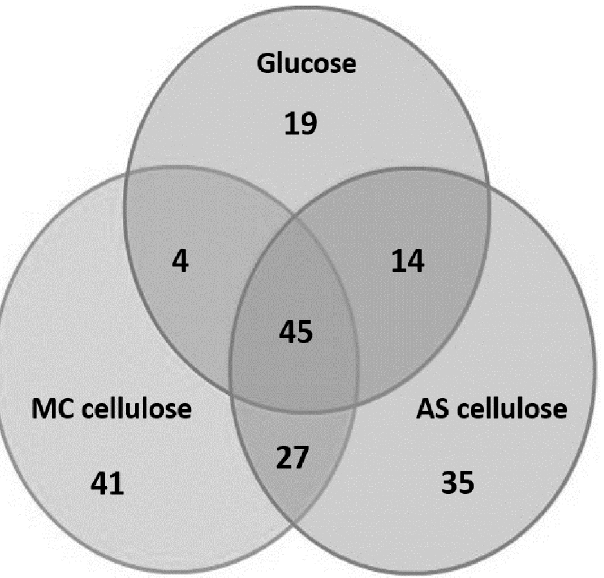
Fig 6. Venn diagram showing distribution of the 185 cell envelope-associated proteins among three different substrate